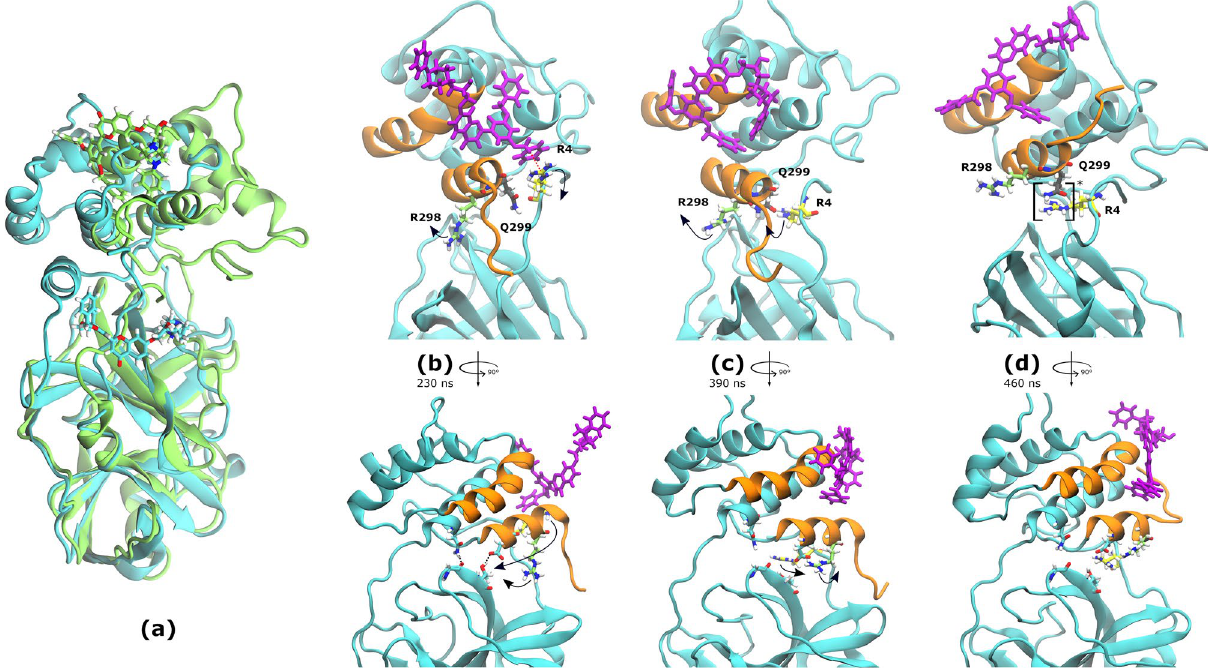
Figure 5. CHEMBL2171598 bound to region B and promoted the reorientation of M PRO domains I/II. ( a ) Superimposition of the initial M PRO complex (cyan; frame 0) to the 600 ns snapshot (green; frame 59,999) over the domain III. CHEMBL2171598 is shown as sticks. Movements of key residues are shown with black arrows. ( b–d ) MD snapshots detailing domain reorganization and the hinge mechanism. Key residues Arg4 (yellow), Arg298 (green) and Gln299 (gray) are displayed as sticks along with their interactions (red dotted lines for π-cation, black for electrostatic). Residues enclosed in [brackets]* are engaging in a polar contact. C-terminal helices (residues 244–257 and 293–306) that interact with the ligand are coloured orange. Lower panels are rotated 90° with respect to upper panels to display interactions between domains I/II and III. Residues participating in those interactions are shown as cyan sticks. Gln299 was removed for clarity. ( b ) CHEMBL2171598 induced the rotation of Arg4. Two polar contacts are observed between domains I/II and domain III: Gly109-Asn203 and Thr111-Asp295. ( c ) Arg4’s rotation reoriented Arg4 and Arg298 side chains in syn conformation. In their new syn conformation, Arg298 and Arg4 guanidinium groups interrupt the hinge movement was triggered shortly after, at 465